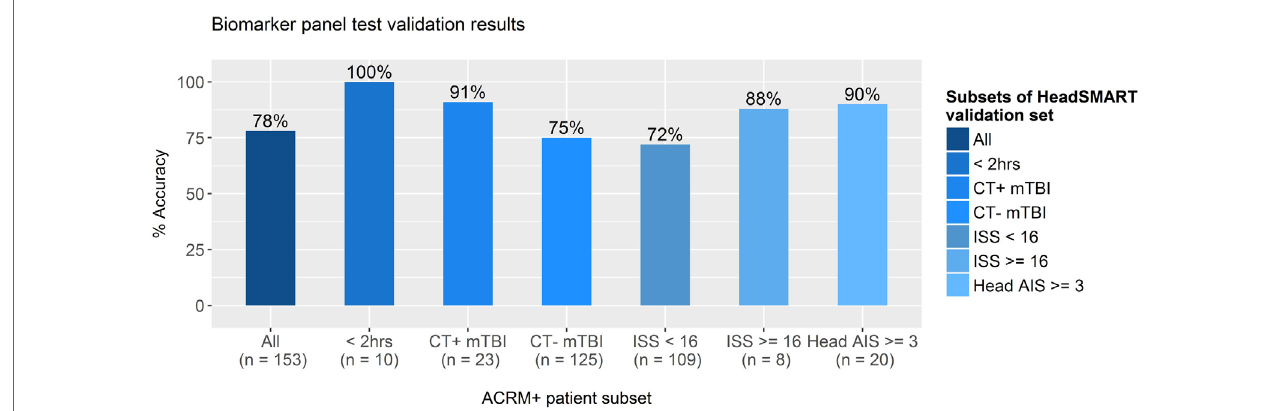
FigUre 6 | Accuracy of test results for clinically distinct subsets of TBI patients. The best performing model, fit in random forest using neurogranin (NRGN), metallothionein 3 (MT3), and neuron-specific enolase (NSE) values, patient age, and sex, was applied to subsets of mild TBI (mTBI) patients in the HeadSMART test set to test the accuracy in classification. Accuracy was assessed in the complete test set (far left bar), the subset patients that met the ACRM + criteria, and mTBI patients with blood samples acquired less than 2 h from the index injury ( < 2 h) were tested with the percentage of accurate calls indicated (%). Computed tomography (CT) positive and CT negative patient subsets were also examined separately to determine the accuracy of the model. Injury severity score (ISS) was evaluated at two separate thresholds to test whether the accuracy of the model biomarker test is affected by injury severity, as well as Head AIS in the subset of patients with high Head AIS ( > 2) without peripheral AIS (AIS = 1 for all categories). Number of samples used to determine the accuracy for each subgroup is indicated below each